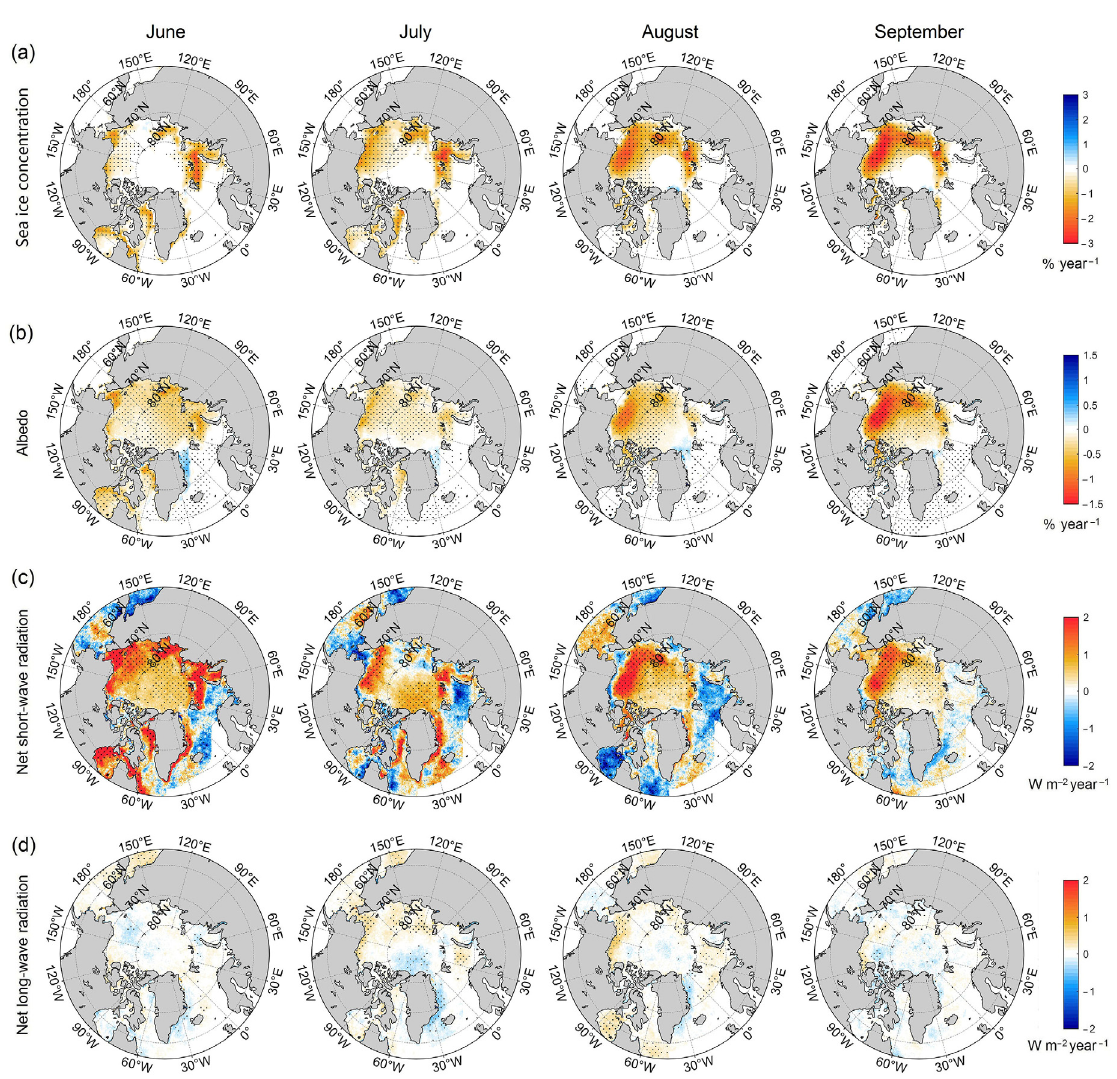
Figure 6. Trend in the satellite-derived Arctic ( a ) monthly sea ice concentration, ( b ) monthly albedo, ( c ) monthly net short-wave radiation, and ( d ) monthly net long-wave radiation for 1982–2018. Black points indicate the trends that are significantly above the 95% confidence